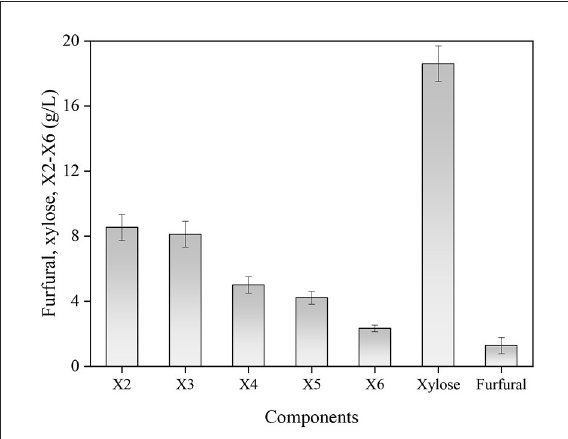
FIGURE4 The distributions of the main components in hydrolysate under the optimum condition. X2, xylobiose; X3, xylotriose; X4, xylotetraose; X5, xylopentaose; X6,